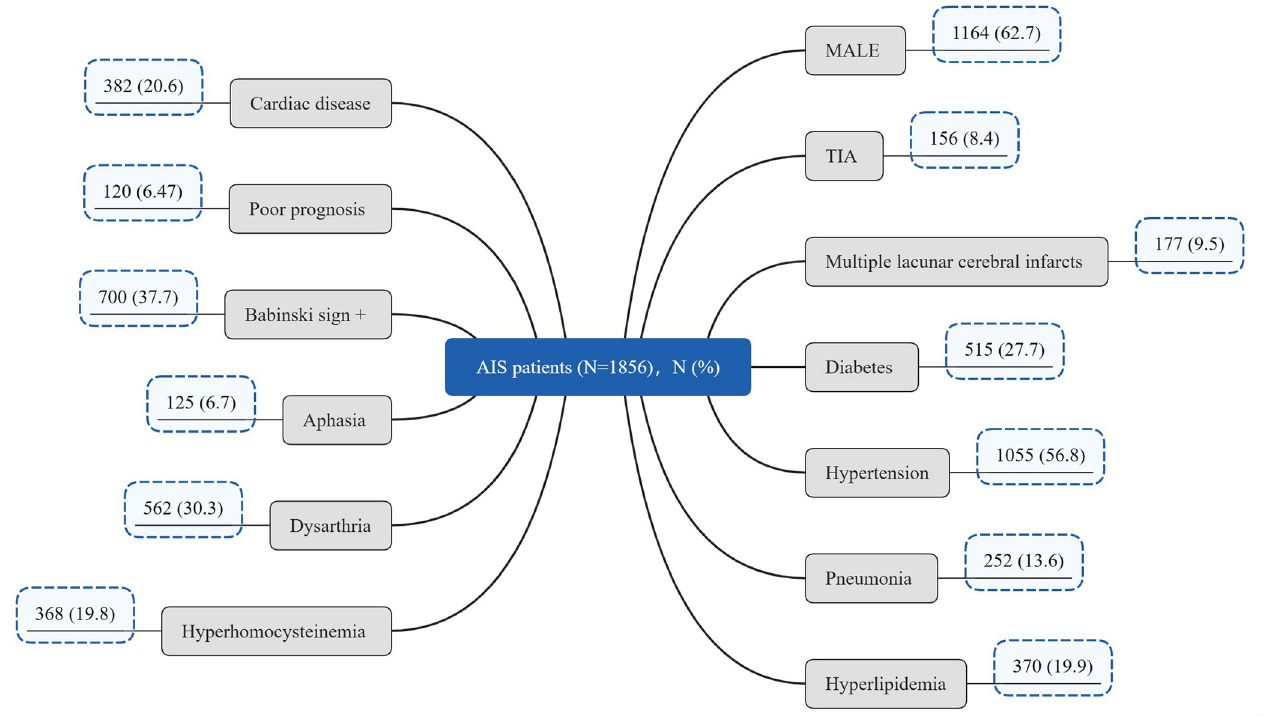
Fig 2. The basic information of the AIS patients in the study. Group W. The median values of following laboratory items: LYMPH#, ESO#, PLT, PTA, ALB, PAB, TG, APOA and APOA/APOB in Group P were significantly lower than those in Group